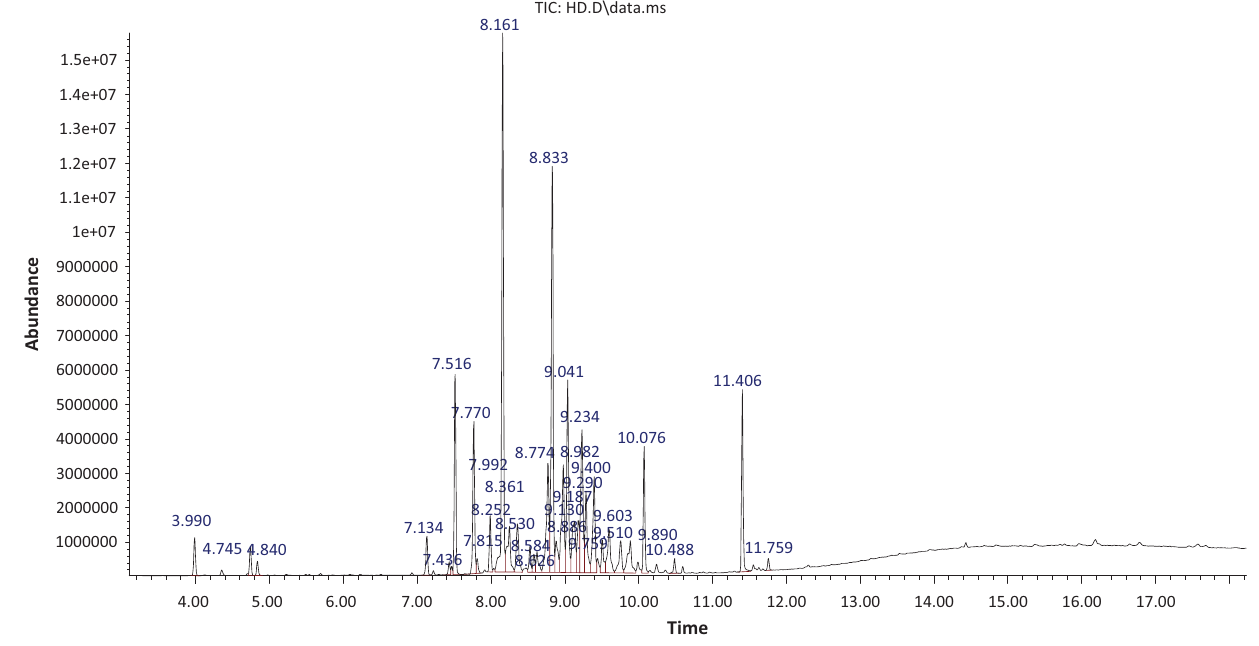
FIGURE 1: Gas chromatography–mass spectroscopy spectral data of Clausena anisata essential oil using hydrodistillation method.